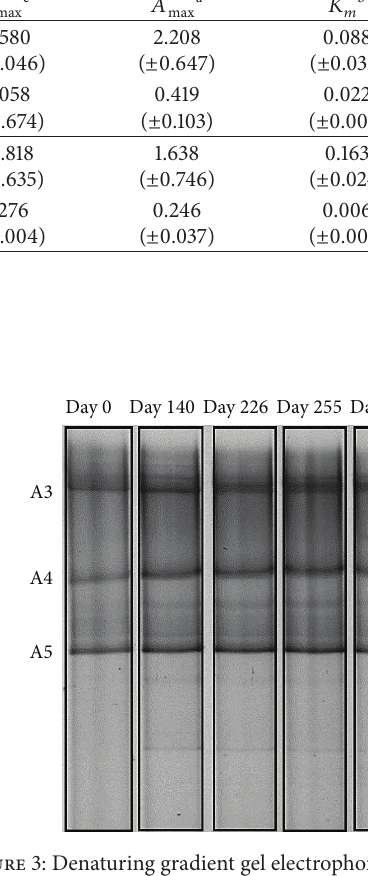
Table 3: Maximum substrate utilising rate, apparent half-saturation constant, and maximum initial (utilising) velocity changes of granular sludge cultivated at 10 ∘ C in the EGSB during 335 days for acetate and H 𝑇 ( ∘ C)